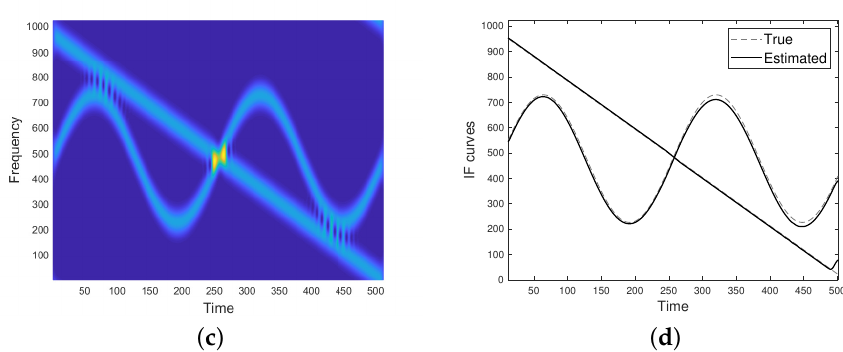
Figure 13. ( a ) Spectrogram of the complex two-component FM signal as in Equation (33), computed with a window of length s = 44. ( b ) IF curves provided by the proposed method applied to ( a ). ( c ) Spectrogram of the complex two-component FM signal as in Equation (33), computed with a window of length s = 22. ( d ) IF curves provided by the proposed method applied to ( c